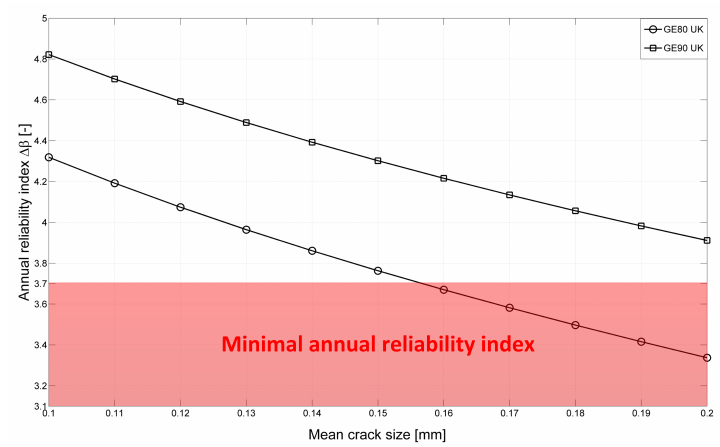
Figure 12. Annual reliability index for different bearings dependent on the mean crack size a . The mean value of friction coefficient µ is set equal to 0.15, and the COV value of the crack size is set constant at 0.66.